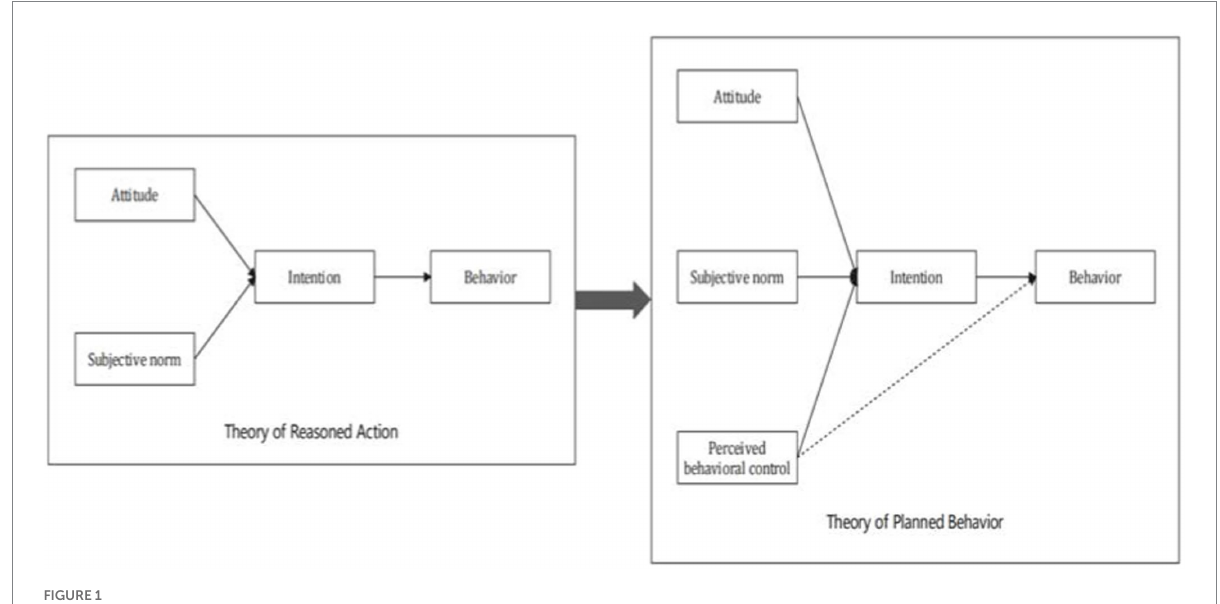
FIGURE 1 From TRA model to TPB